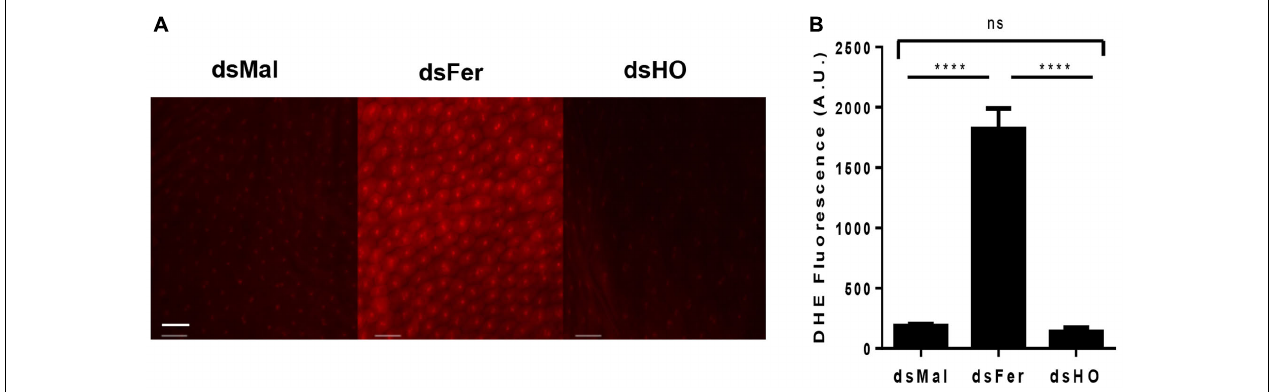
FIGURE 12 | Effect of gene silencing in the production of ROS in the midgut of adult insects. Starved adult females were injected with 1 µ g of dsRNA of ferritin or heme oxygenase (HO). After 48 h, the animals were fed on blood. Dissected posterior midguts were incubated at 28 ◦ C for 30 min in a solution containing 100 µ M DHE. dsMal-injected females were used as a control. The tissues were analyzed by Fluorescence Microscopy (Zeiss Axio Observer Microscope) using a 20 × lens with 80 ms exposure time for all conditions. (A) The images are representative of a total of 12 intestines analyzed. (B) Quantification of fluorescence using Zeiss Axio Observer Quantification software. P = 0.0016. One-way ANOVA with Tukey post test. ∗∗∗∗ p < 0.0001 scale bar 2 µ